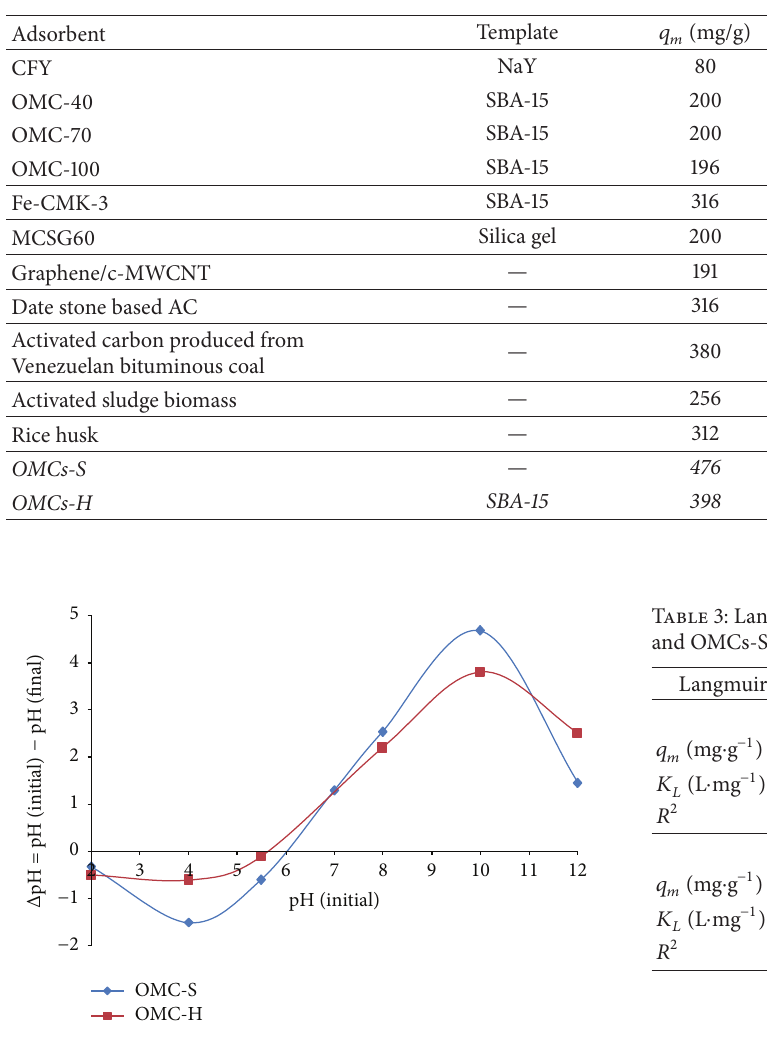
Table 2: Comparison of MB adsorption capacity for different adsorbents.